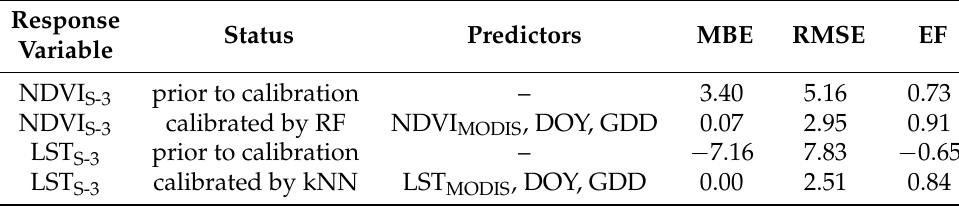
Table 2. Accuracy of MODIS NDVI and LST cross-calibration to Sentinel-3 counterparts.